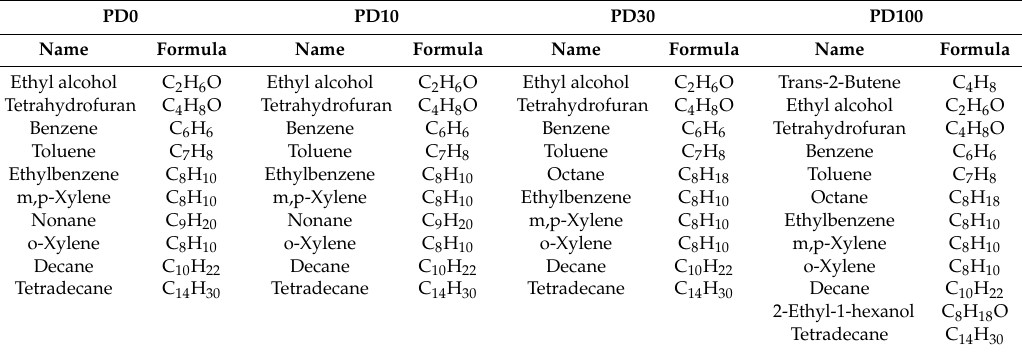
Table 9. List of VOCs observed under an engine load of 40